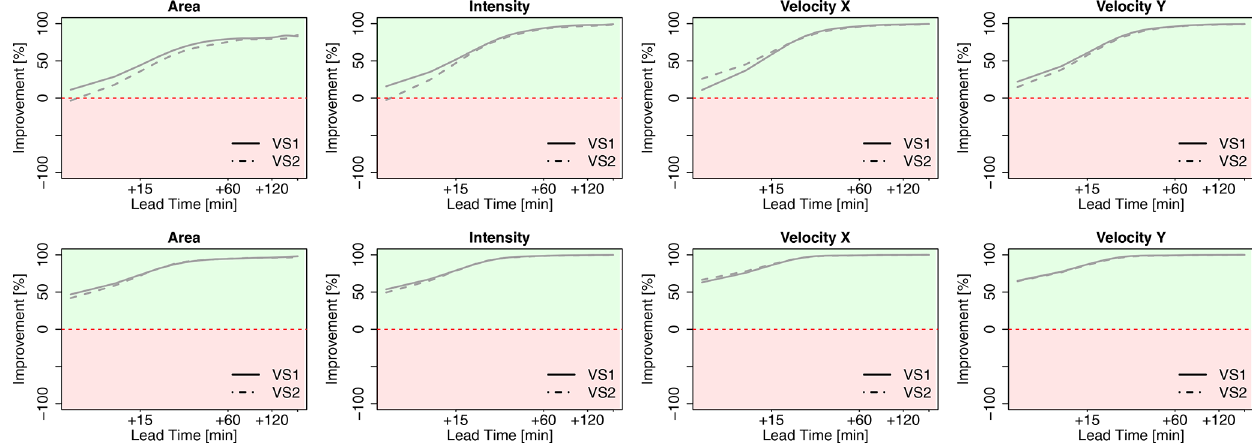
Figure 15. Median performance improvement over the 110 events for each of the target variables nowcasted from 4-NN deterministic (upper row) and 30NNs probabilistic (lower row) applications when compared to the Lagrangian persistence for both target- (dashed line) and storm-based (solid line) approaches. The results shown here are from the “unmatched storms” when nowcast time is